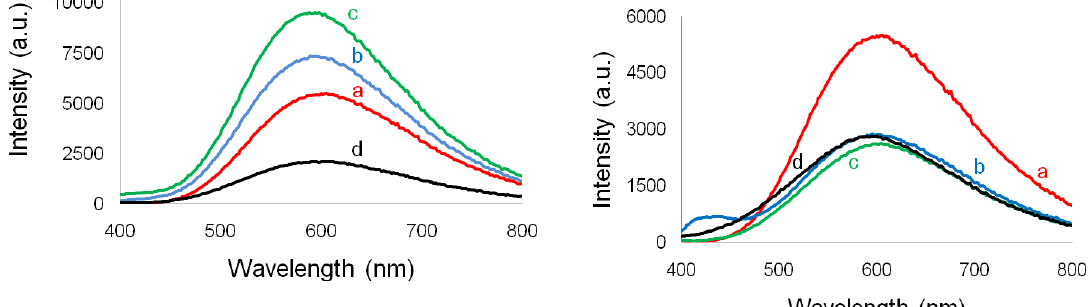
Figure 10. Left: Photoluminescence spectra of ZnO NPs obtained without PyQAs1 ( a ) and with 1% ( b ), 2.5% ( c ), and 5% ( d ) PyQAs1. Right: Photoluminescence spectra of ZnO NPs obtained without PyQAs2 ( a ) and with 1% ( b ), 2.5% ( c ), and 5% ( d ) PyQAs2.